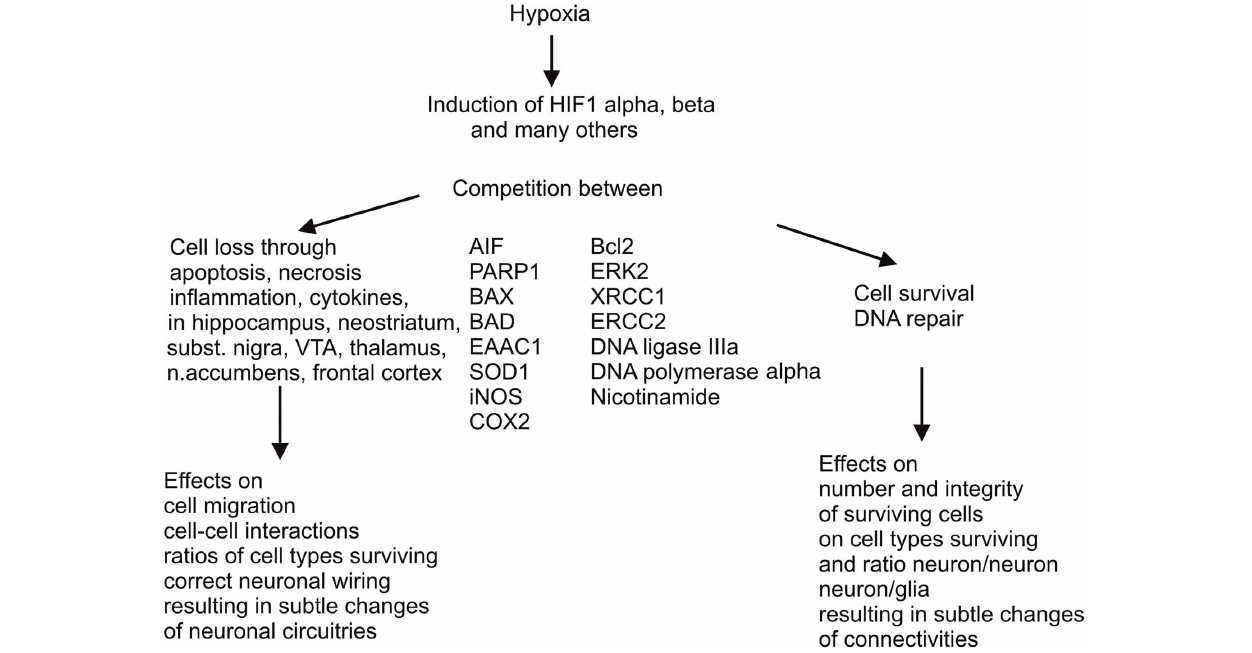
various mechanisms of action could support these compensatory mechanisms if given systemically as a therapeutic means. In any case, both cell loss and cell rescue eventually entail more or less subtle consequences on brain development, neuronal wiring, and neuron glia interactions. These tentatively negative consequences are probably reinforced by additional negative impact during development (puberty and adolescence), resulting in psychiatric disorders if not aggravating neurological